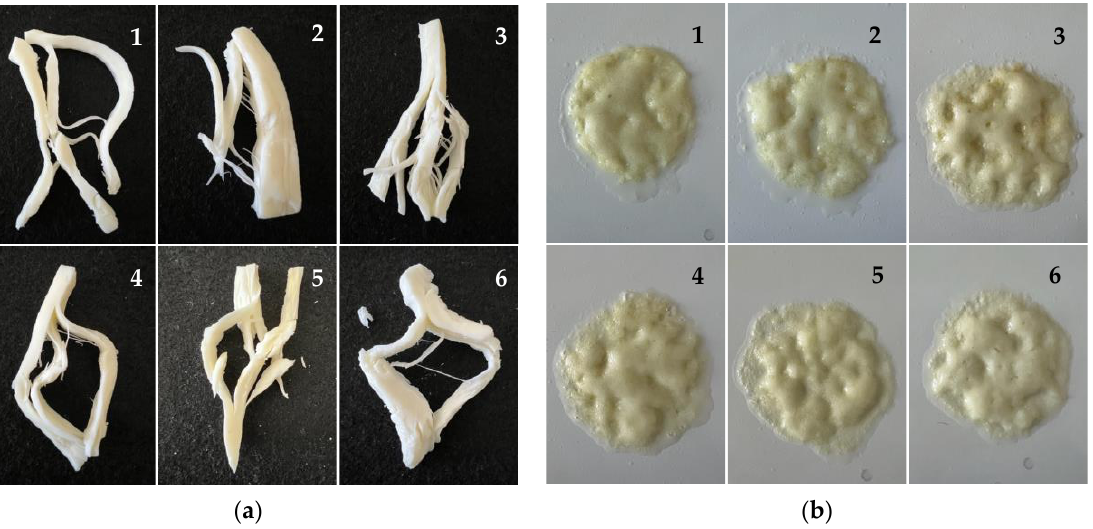
Figure 3. Thread-forming capacity ( a ) and meltability ( b ) of Oaxaca cheese made with ultrasonicated raw milk: (1) 25 kHz for 0 min, (2) 25 kHz for 15 min, (3) 25 kHz for 30 min, (4) 45 kHz for 0 min, (5) 45 kHz for 15 min, and (6) 45 kHz for 30 min.